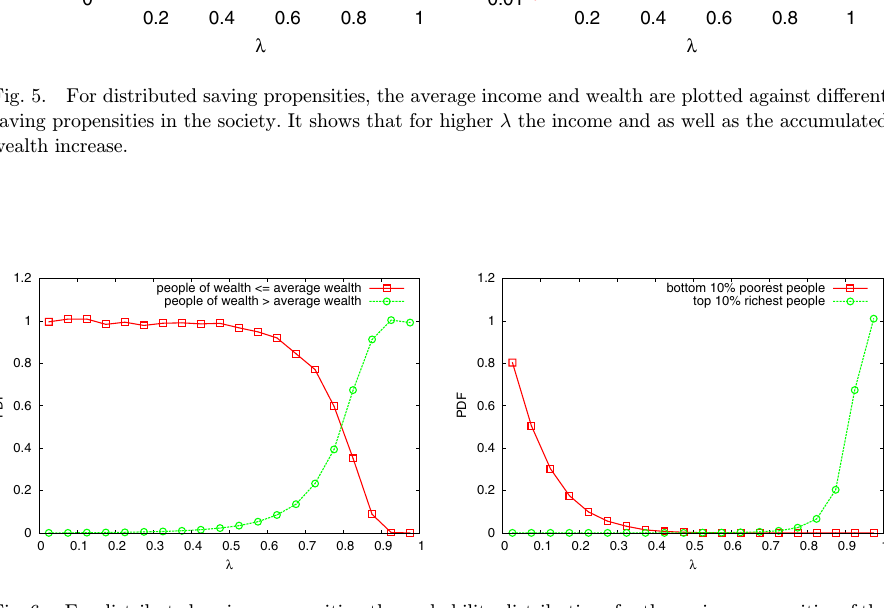
Fig. 6. For distributed saving propensities, the probability distributions for the saving propensities of the rich and poor sections of the society are plotted. On the left, the poverty line is just the average wealth, while on the right we de¯ne poor and rich as the bottom and top 10% of the society. In general, high savings lead to higher wealth.